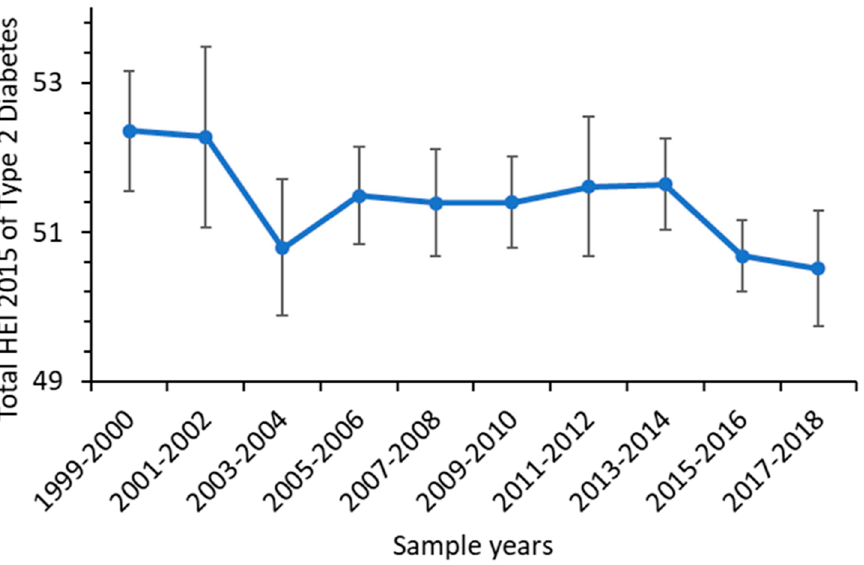
Figure 2. Total HEI-2015 scores of US type 2 diabetic adults from 1999–2000 to 2017–2018.